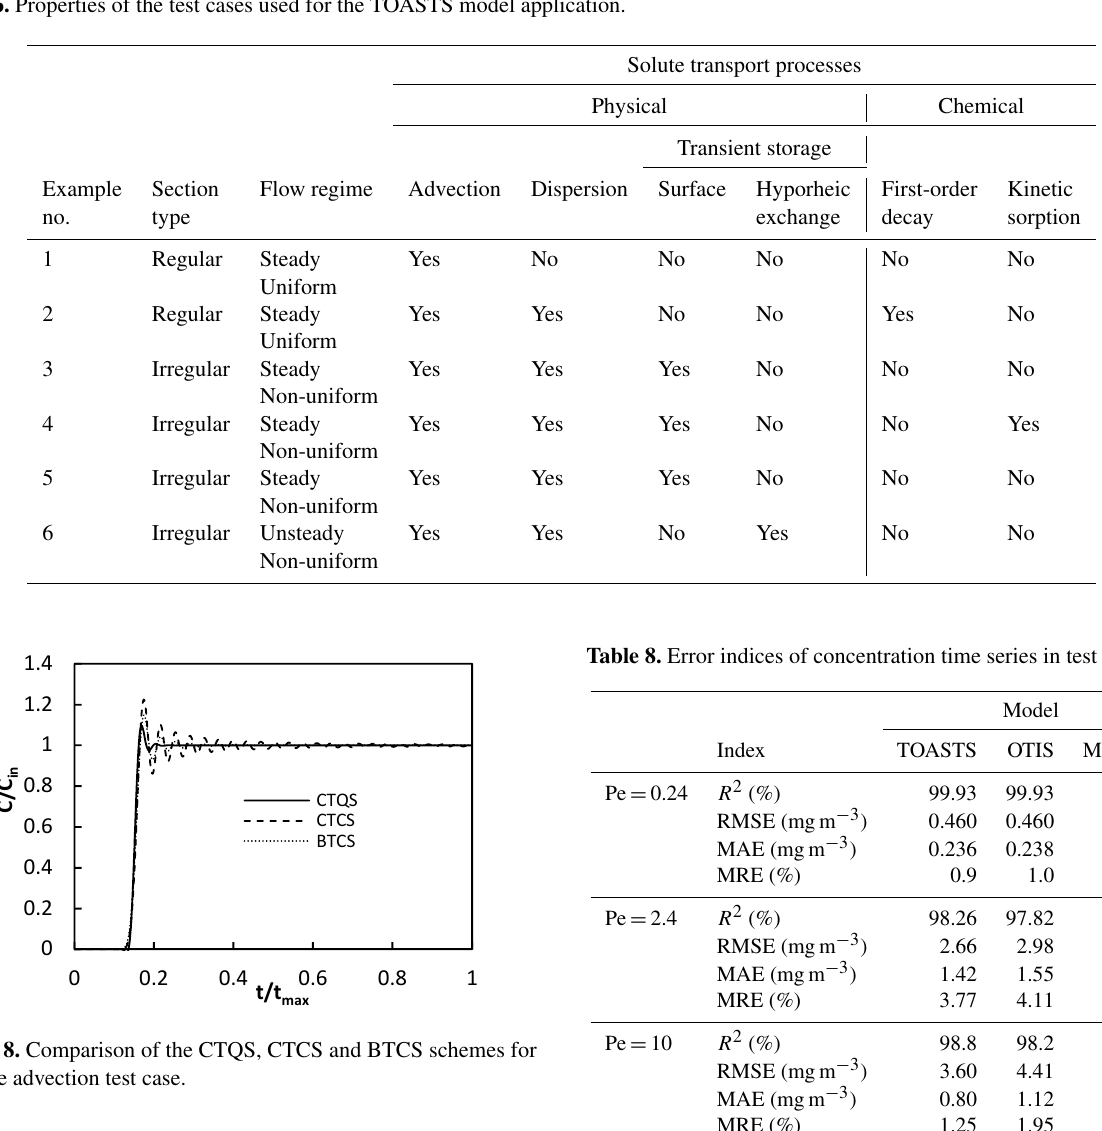
Table 6. Properties of the test cases used for the TOASTS model application.